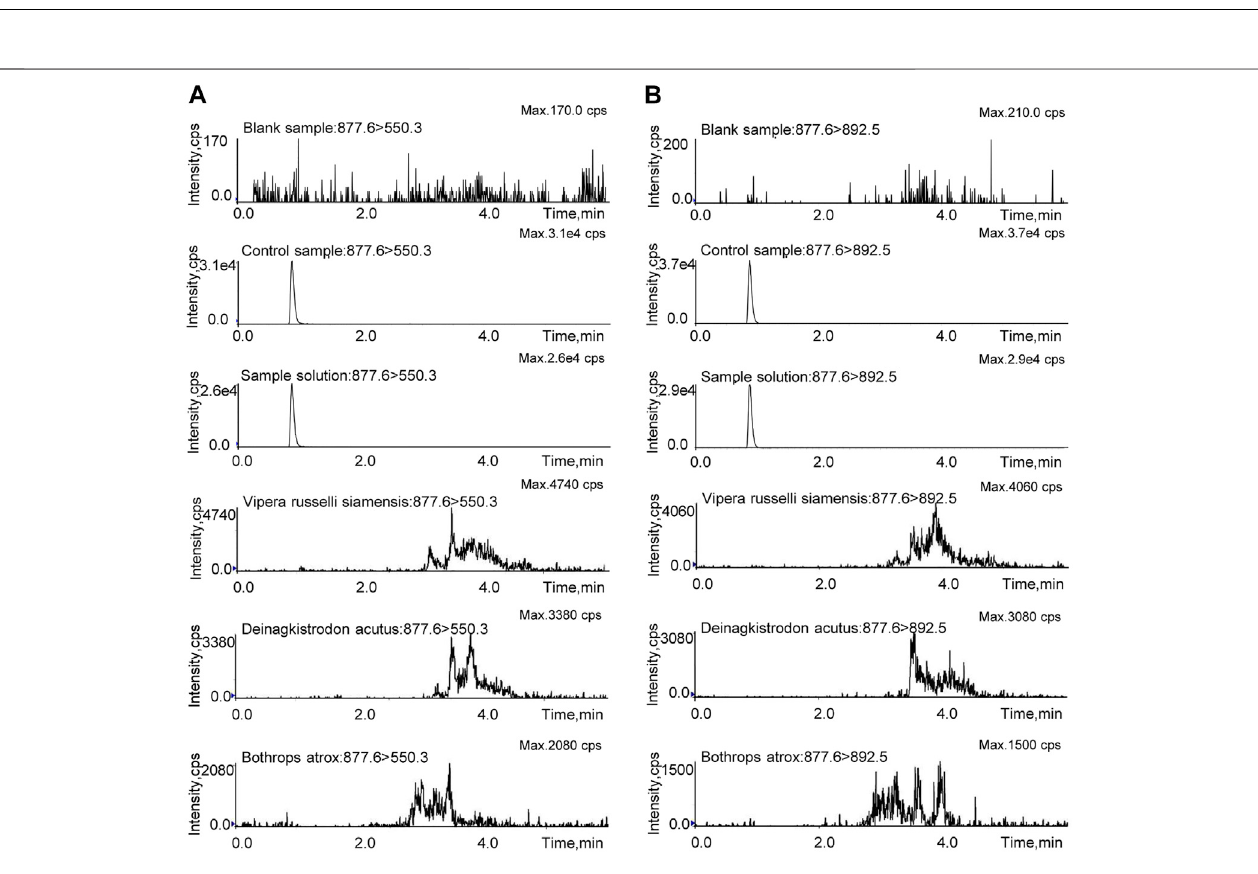
FIGURE 5 | MRM investigation of TLCAGVMEGGIDTCNR in the blank sample, control sample, sample solution, and the other snake venom samples. (A) Qualitative ion pair (m/z = 877.6 > 550.3). (B) Quantitative ion pair (m/z = 877.6 > 892.5).